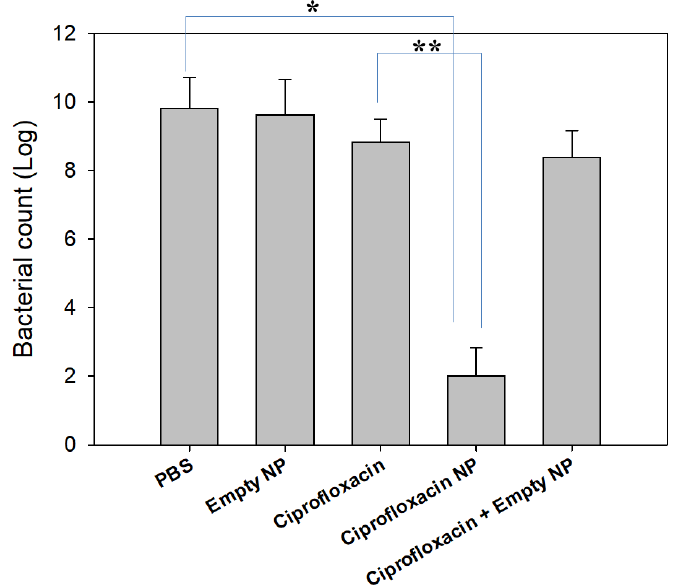
Figure 6. Antibacterial activity of CIP-incorporated nanoparticles. CIP (0.1 mg CIP/0.5 mL PBS) and nanoparticles in PBS solution (0.1 mg as a CIP concentration in 0.5 mL PBS) was introduced into dialysis membrane. Same quantity of empty nanoparticles or empty nanoparticles with free CIP in dialysis membrane were used to compare. For control treatment, 0.5 mL PBS in dialysis membrane was used. To assess the antibacterial activity of CIP-incorporated nanoparticles, CIP-incorporated nanoparticles (drug content: 10.1% ( w / w )) were used. *, p < 0.01; **, p < 0.01.